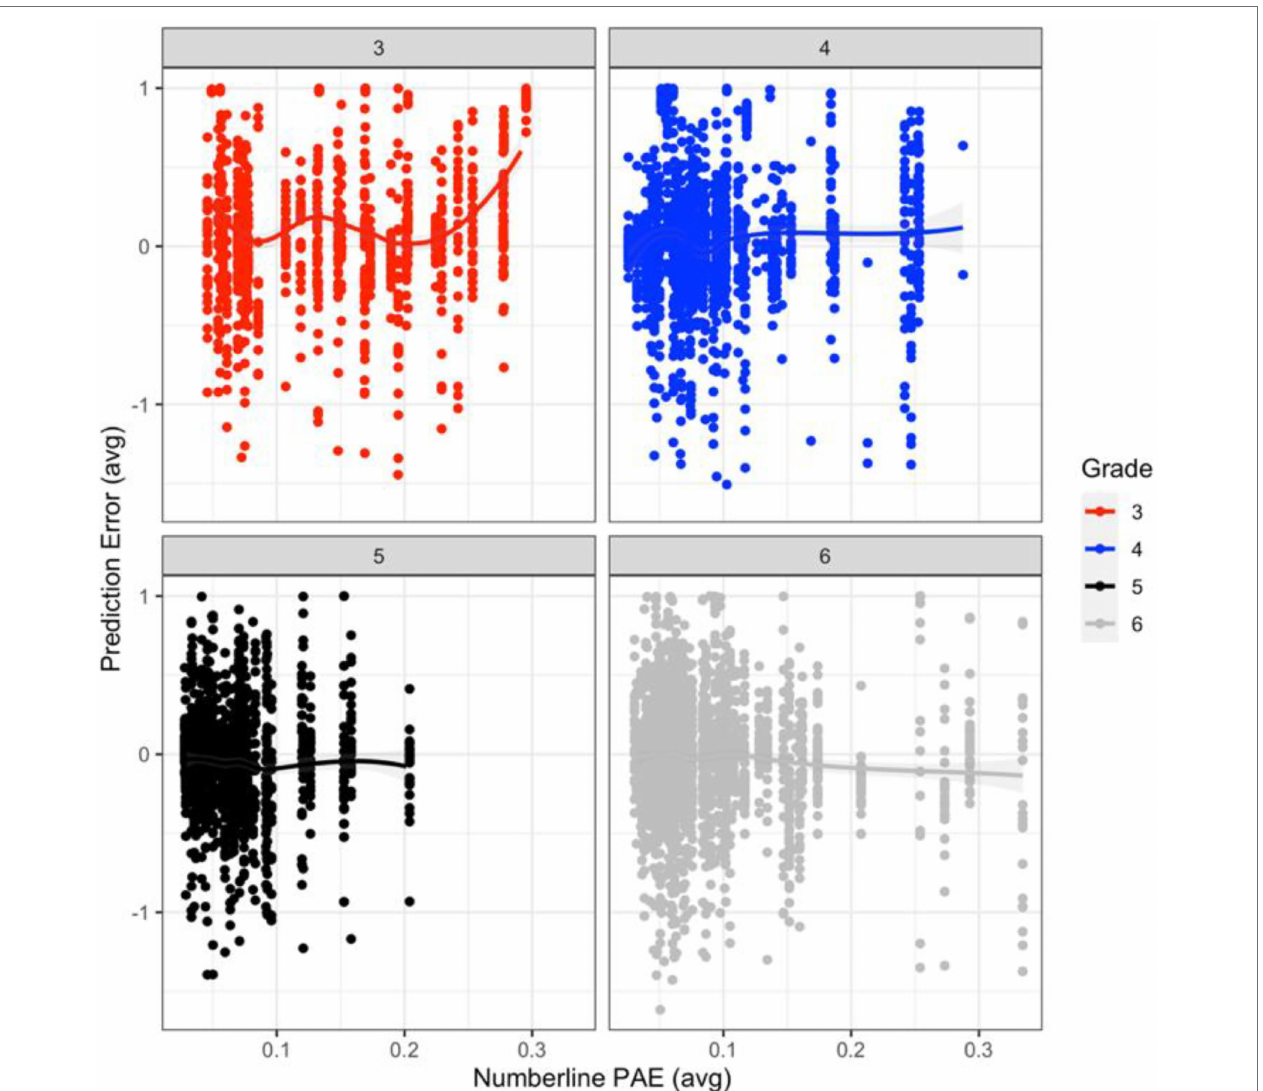
FIGURE 1 | Relation between mean prediction error (PE) and number line percent absolute error (PAE), with SEs (gray shading) by grade